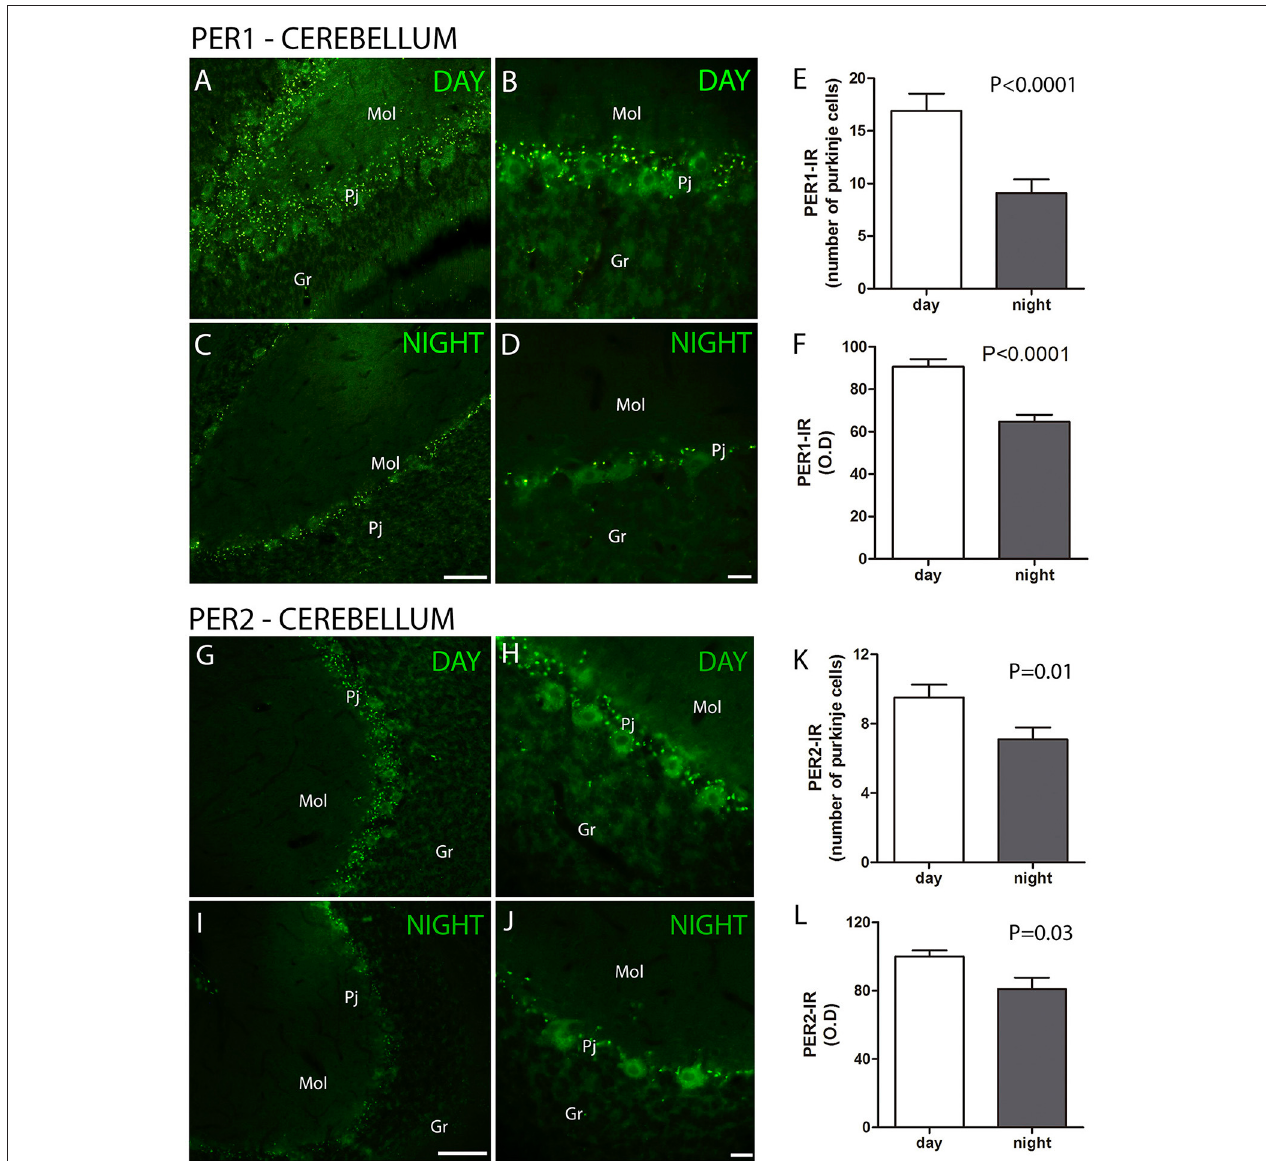
FIGURE 1 | The distribution of PER1 and PER2 proteins in the cerebellar cortex in the primate Sapajus apella. Photomicrographs of frontal brain sections show PER1-IR cells (A–D) (green) or PER2-IR cells (G–J) at two time points, one during the day (ZT 10) and another at night (C,D) . The graphs show the means ± standard error of the mean of the number (E) and IR intensity (O.D) quantification (F) of PER1-IR (E,F) or PER2-IR (K,L) cells in the Purkinje cell layers of monkeys perfused at day or nighttime points. Bar = 100 or 50 µ m. Purkinje cell layer (Pj); molecular layer (mol); granular layer (Gr).